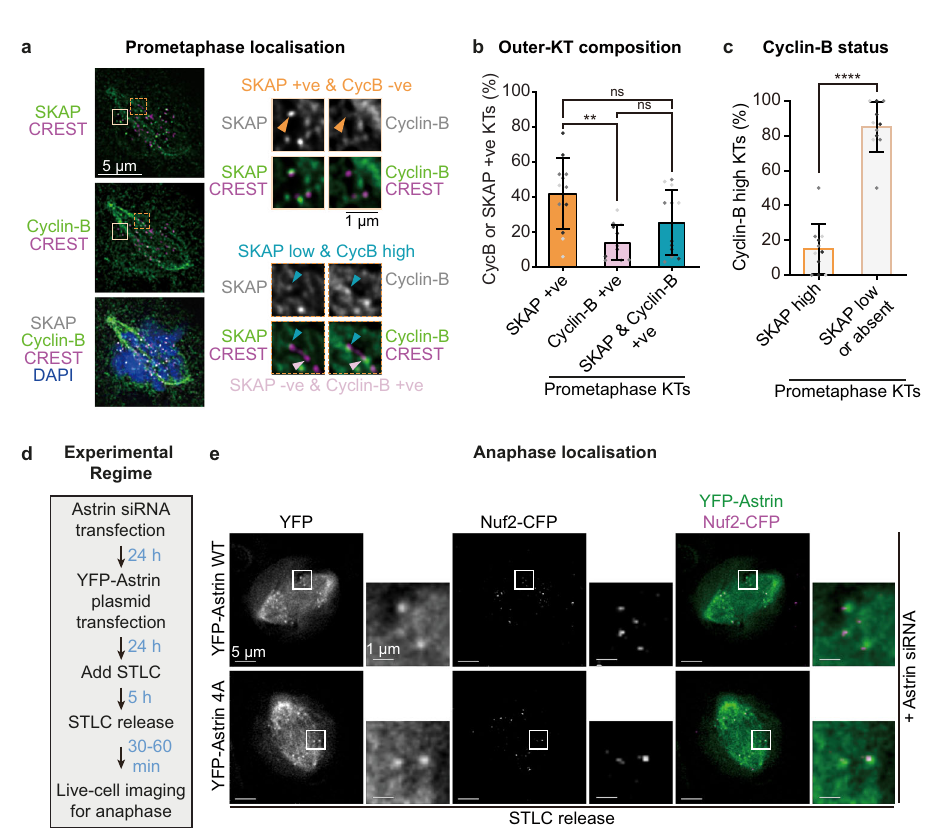
Fig. 6 CDK1 and Astrin-PP1 counteract each other at the outer-kinetochore. a Images of RPE1 cells immunostained with antibodies against Cyclin-B and SKAP, and CREST anti-sera, and co-stained with DAPI for DNA. Arrowheads mark kinetochores with low SKAP and high Cyclin-B intensities (blue), SKAP- positive ( + ve) and Cyclin-B-negative ( − ve) kinetochore (orange), SKAP-negative (-ve) and Cyclin-B positive ( + ve) kinetochore (pink). Scale bar as indicated. b Graph of the percentage of kinetochores enriched for either Cyclin-B or SKAP or both, ascertained using images as in a . ‘ * ’ and ‘ ns ’ indicates signi fi cant and insigni fi cant statistical difference, respectively, determined using Non-parametric Kruskal-Wallis H test combined with Dunn ’ s multiple comparisons test. c Graph of percentage of Cyclin-B positive kinetochores with SKAP-high or − low intensities as in a . ‘ * ’ indicates statistical difference tested with two-tailed Mann Whitney test. Height of bars and whiskers ( b and c ) mark average value and standard deviation, respectively. Dots in the same shade of grey are from the same experimental repeat ( n = 723 kinetochores, 12 cells and 3 independent experimental repeats). d Experimental regime to assess anaphase kinetochores: Astrin siRNA transfected cells coexpressing Nuf2-CFP (kinetochore marker) and either YFP-Astrin WT or YFP-Astrin 4A mutant were exposed to STLC for 5 h to synchronise monopolar spindles. After STLC was washed out to release cells into anaphase for live-cell imaging. e Representative anaphase live-cell images of mono-oriented kinetochores displaying YFP-Astrin WT or 4A crescents in cells treated as in d Sample size: WT (4 cells) and 4A (7 cells) from 2 independent experimental repeats. Scale as